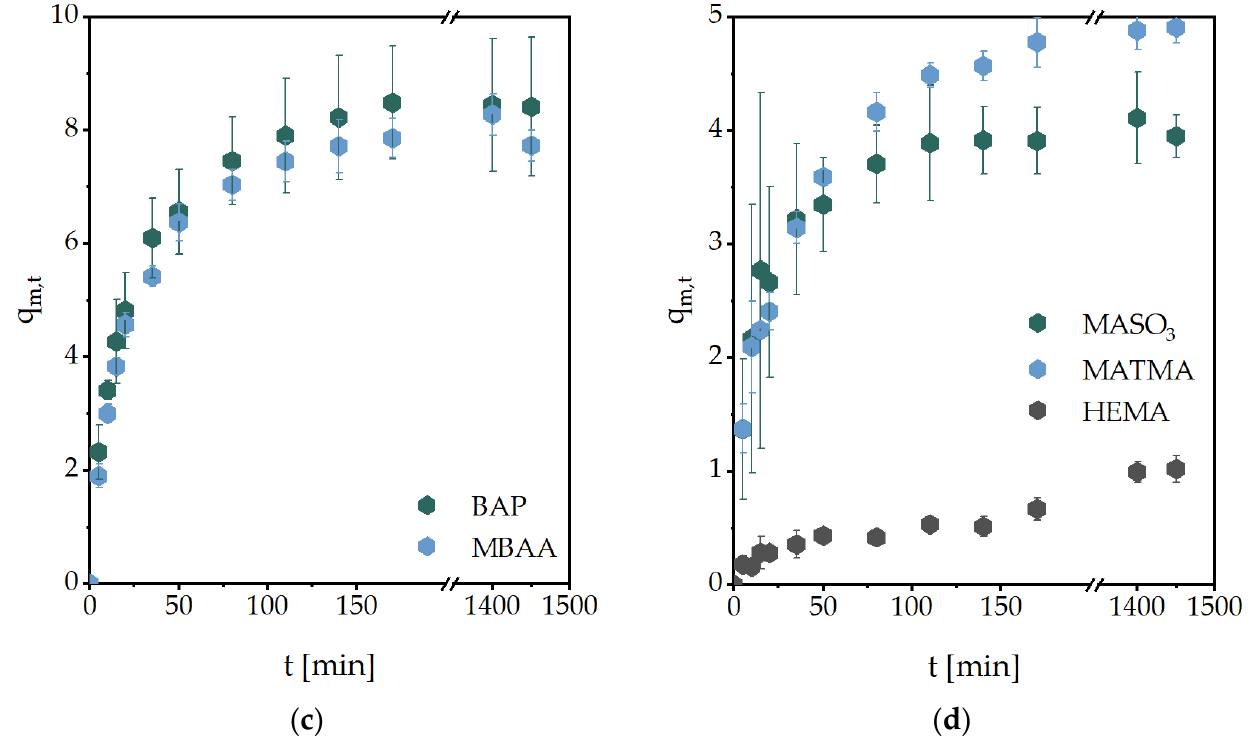
Figure 1. Water swelling kinetics of ( a ) MASO 3 (2 mol/L) hydrogels with BAP (2 mol%) as a crosslinker, ( b ) MASO 3 with different monomer concentrations and BAP as a crosslinker, ( c ) MASO 3 (2 mol/L) and different crosslinkers (2 mol%) and ( d ) hydrogels with different monomer structures (3 mol/L) and BAP (2 mol%) as a crosslinker. All measurements were performed in triplicate, at 36 ± 1 °C in PBS.